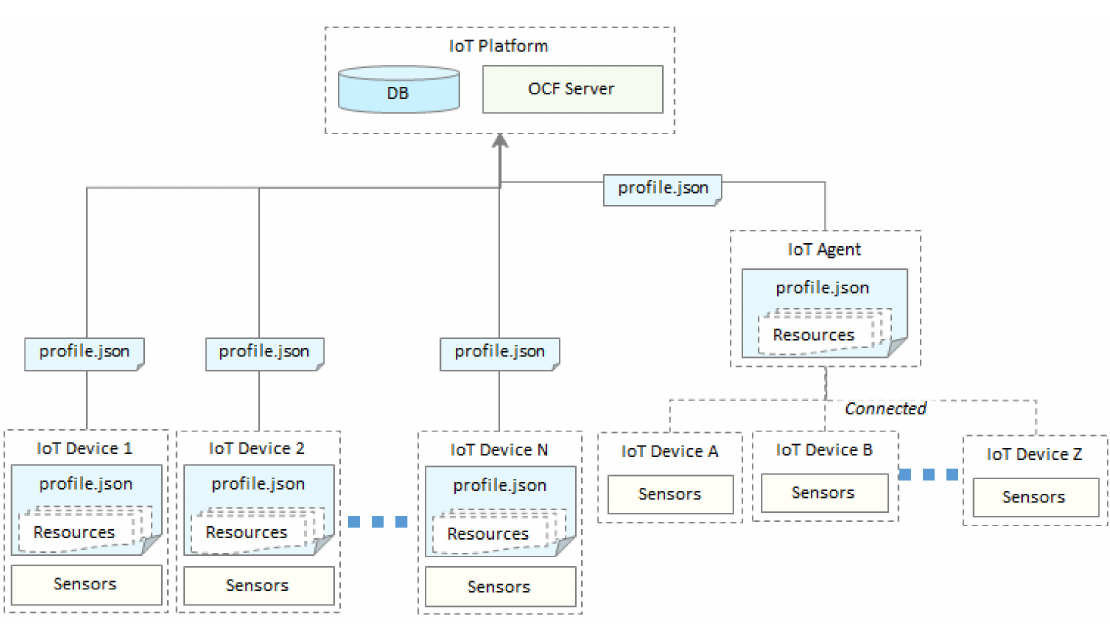
Figure 2. Self-registration using the profile in the IoT